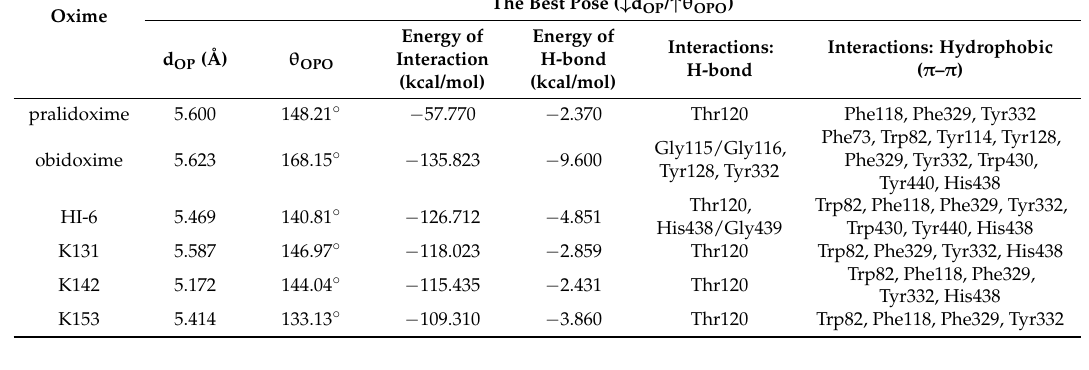
Table 3. Docking results for the complex Hss BChE/POX.